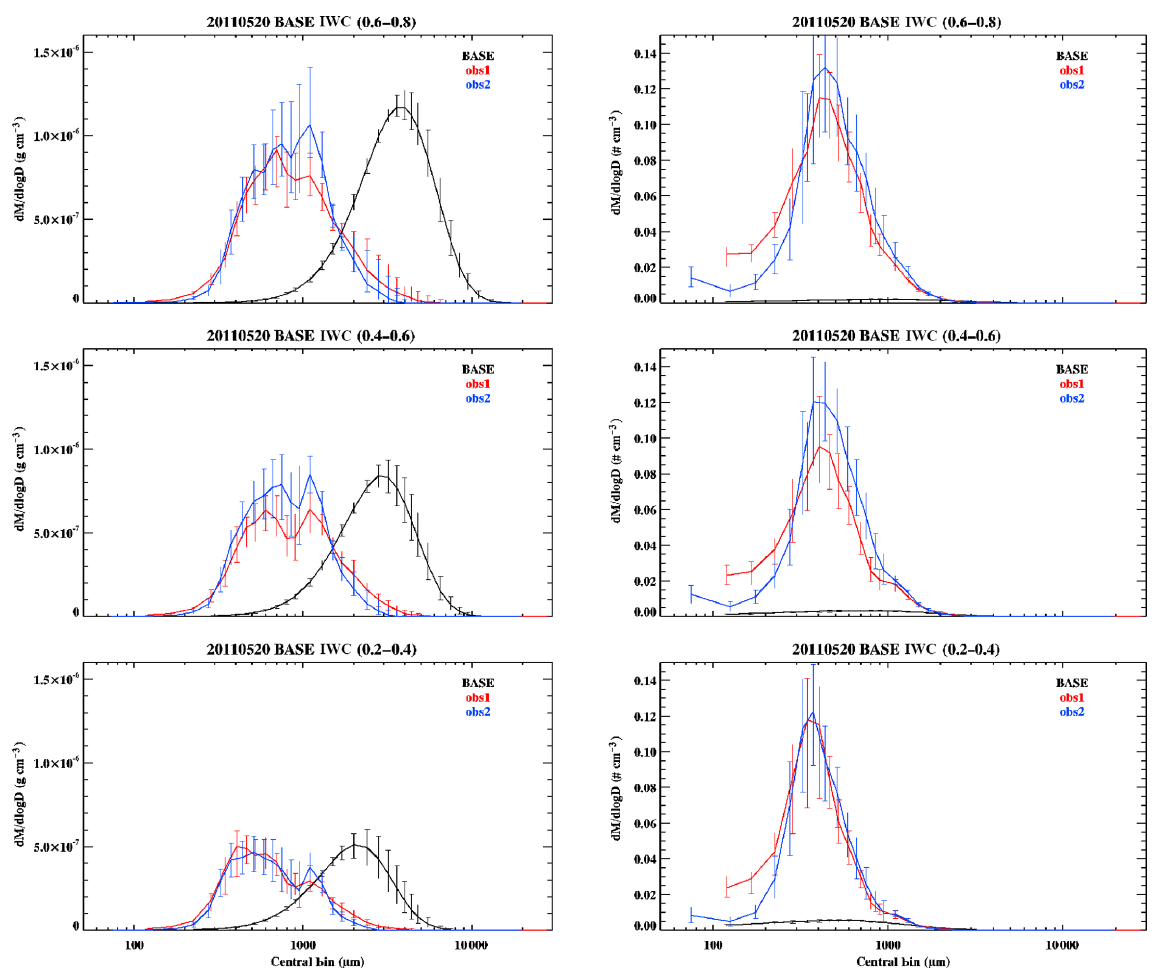
Figure 12. The same as Fig. 11 except at 6.7km ( − 16 ◦ C). No IWC greater than 0.8gm − 3 was measured at 6.7km.